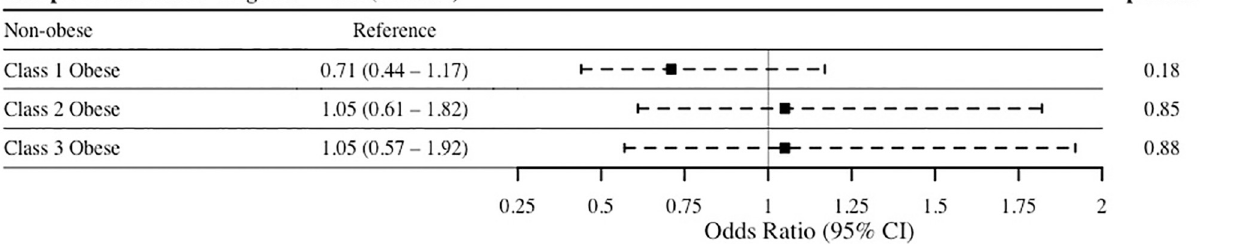
Fig 3. Unadjusted multivariable logistic regression of composite outcome. Composite outcome represents readmission, reoperation, or complications. Outcome regressed on obesity categories, with non-obese (BMI < 30 kg/m 2 ) patients used as the reference group. Abbreviations: OR, odds ratio; CI, confidence interval.